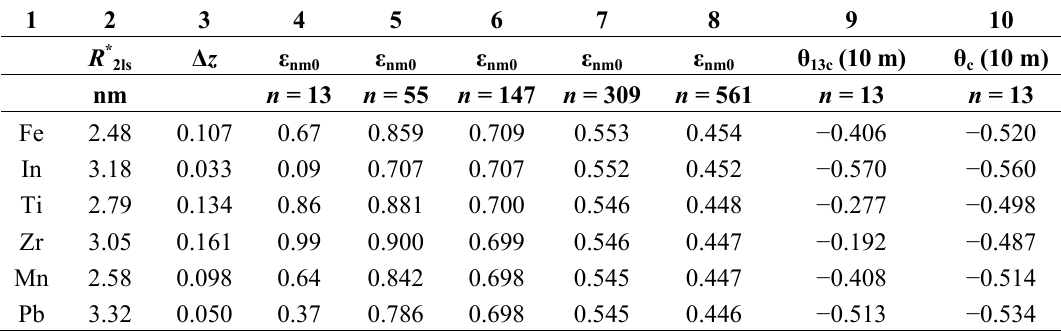
Table 2. Energy saving coefficients ε temperatures θ of 13-atom superclusters inducing spontaneous growth at θ 13c in 10 micrometer